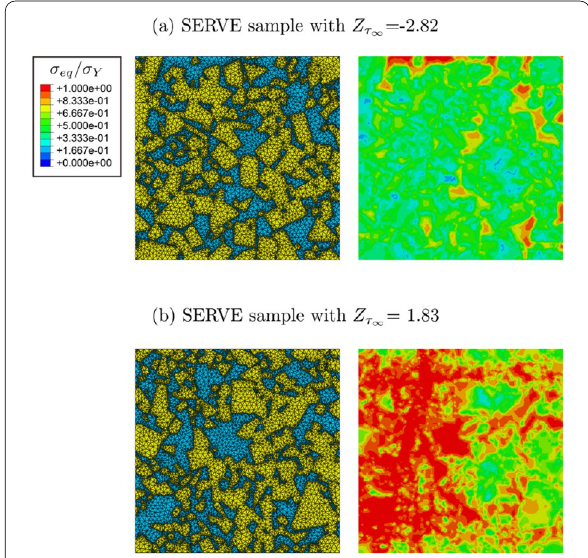
Figure 10 Stress fields in samples with different Z τ